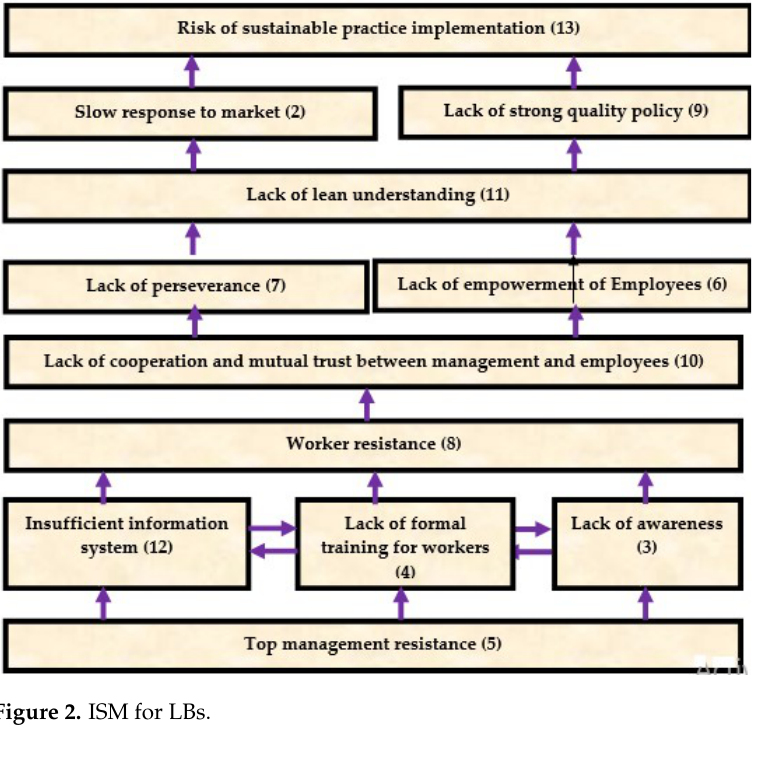
Figure 1. The research methodology.